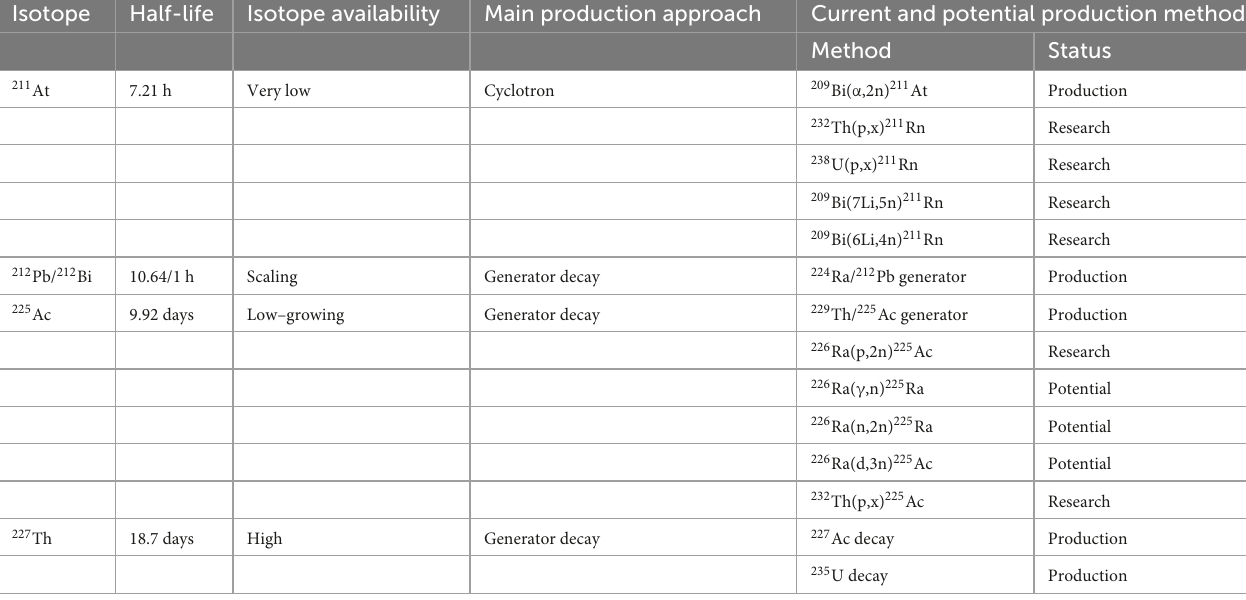
TABLE 3 Overview of current and potential production methods for four key alpha-emitting isotopes.